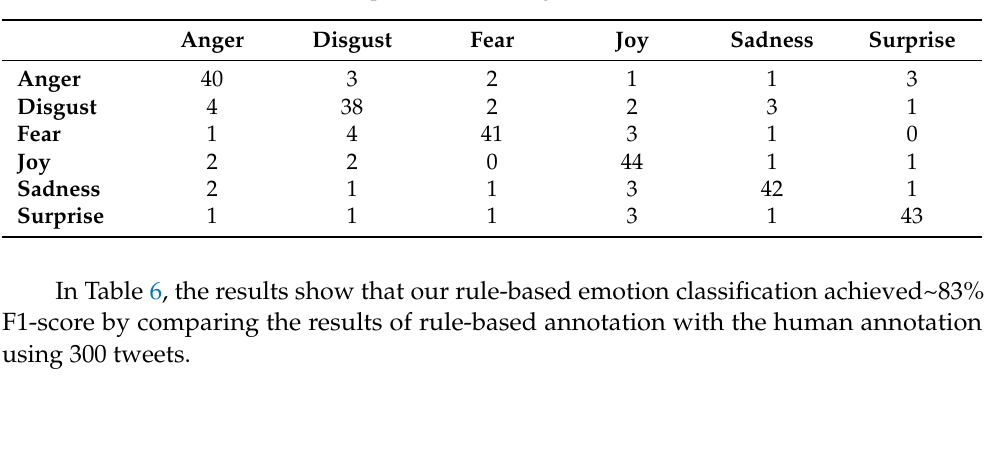
Table 5. Confusion matrix of the comparison between ground truth and automatic